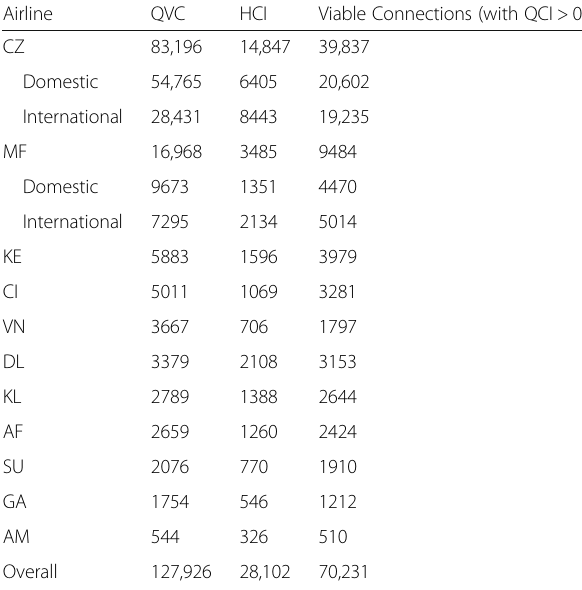
Table 3 SkyTeam partners ’ contributions (by